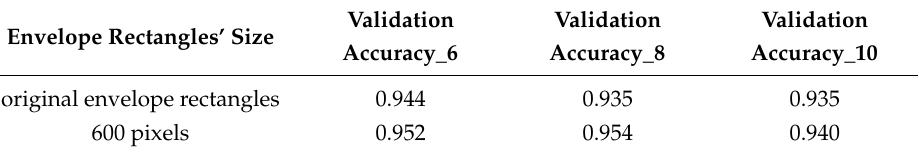
Table 2. Validation accuracy of model under fine-tuning.